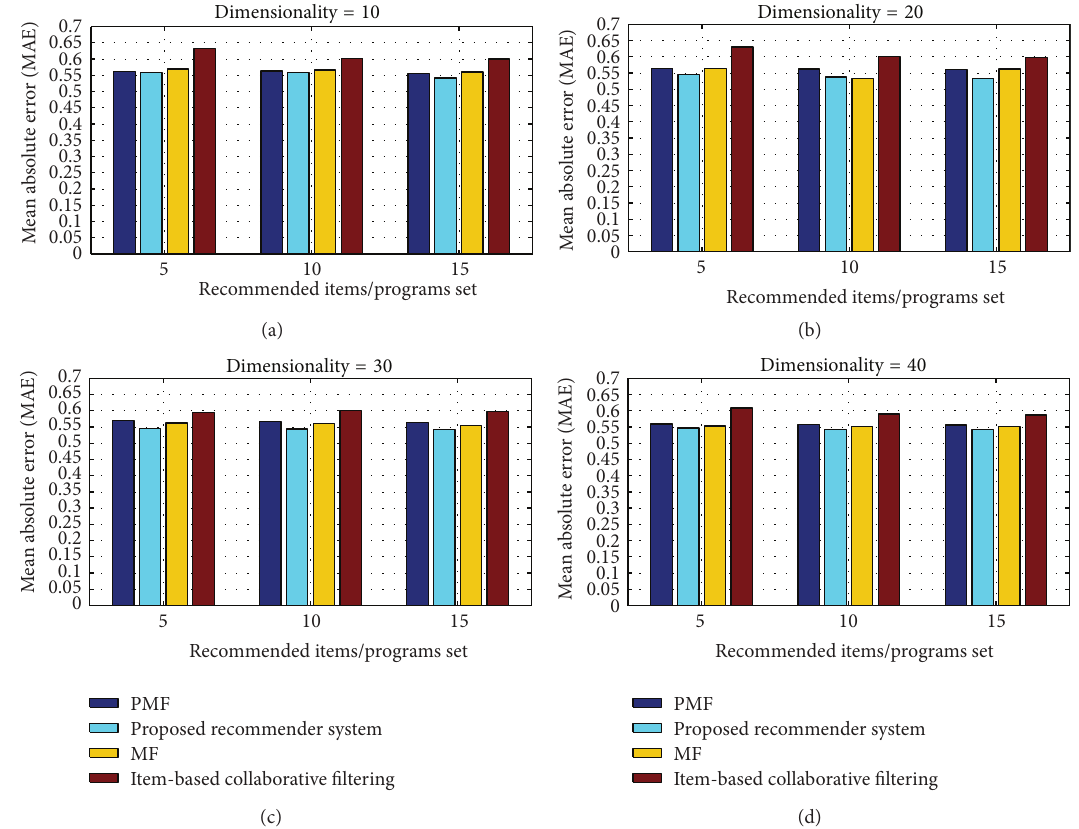
Figure 12: Comparison of MAE of 𝑃@𝑁 at different dimension of latent